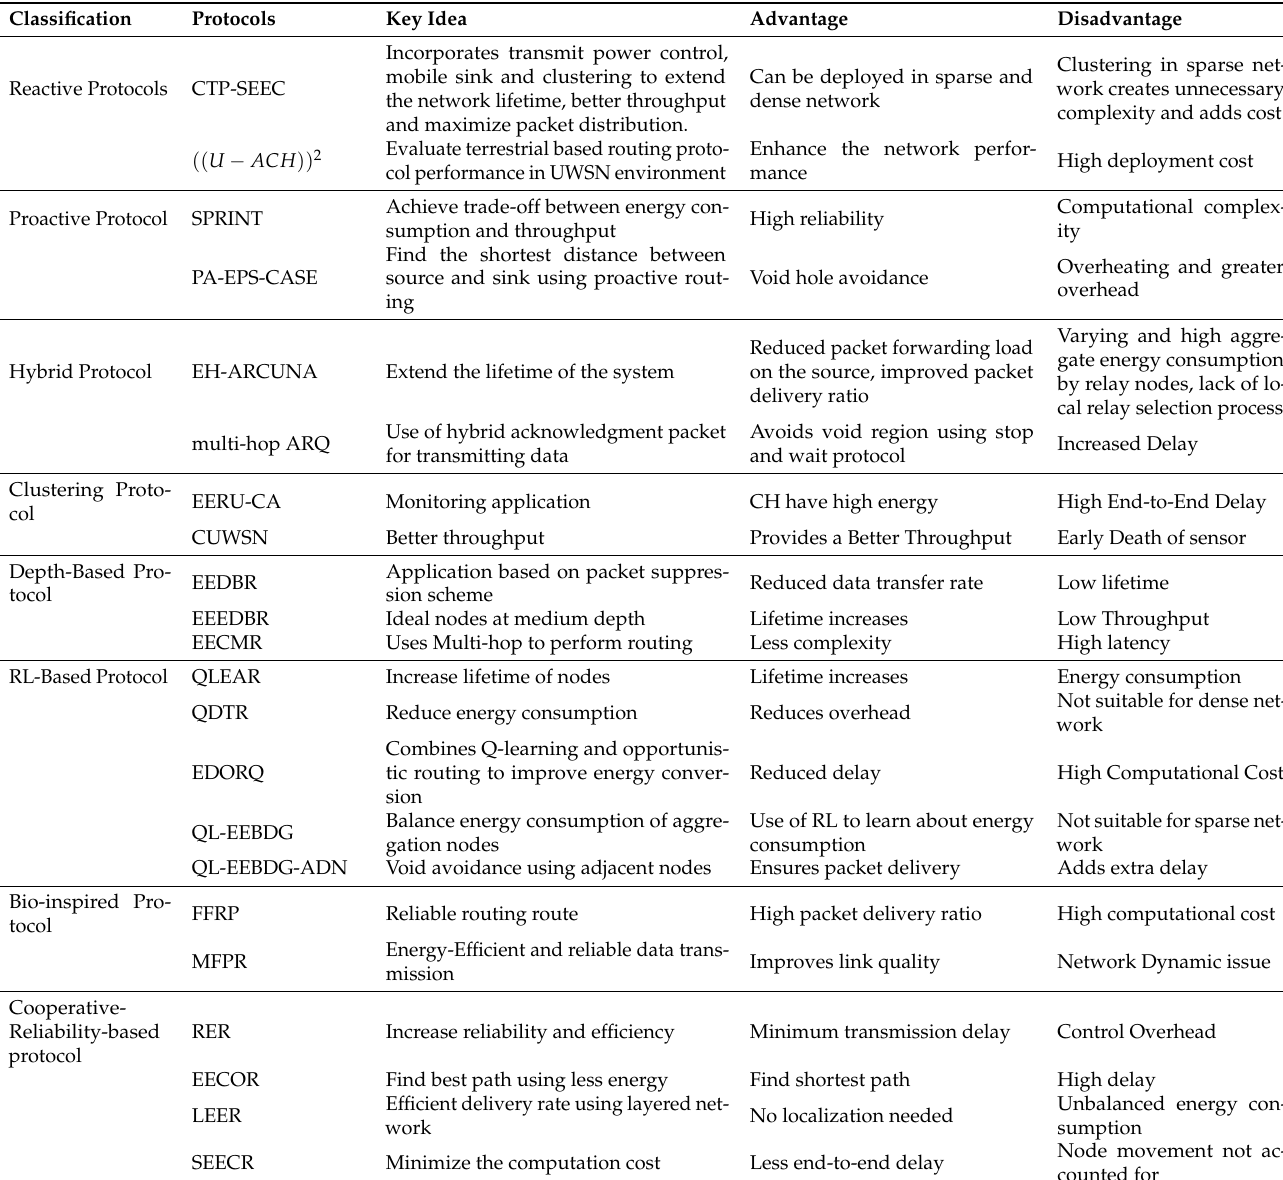
Table 10. Comparison of Energy-based Routing